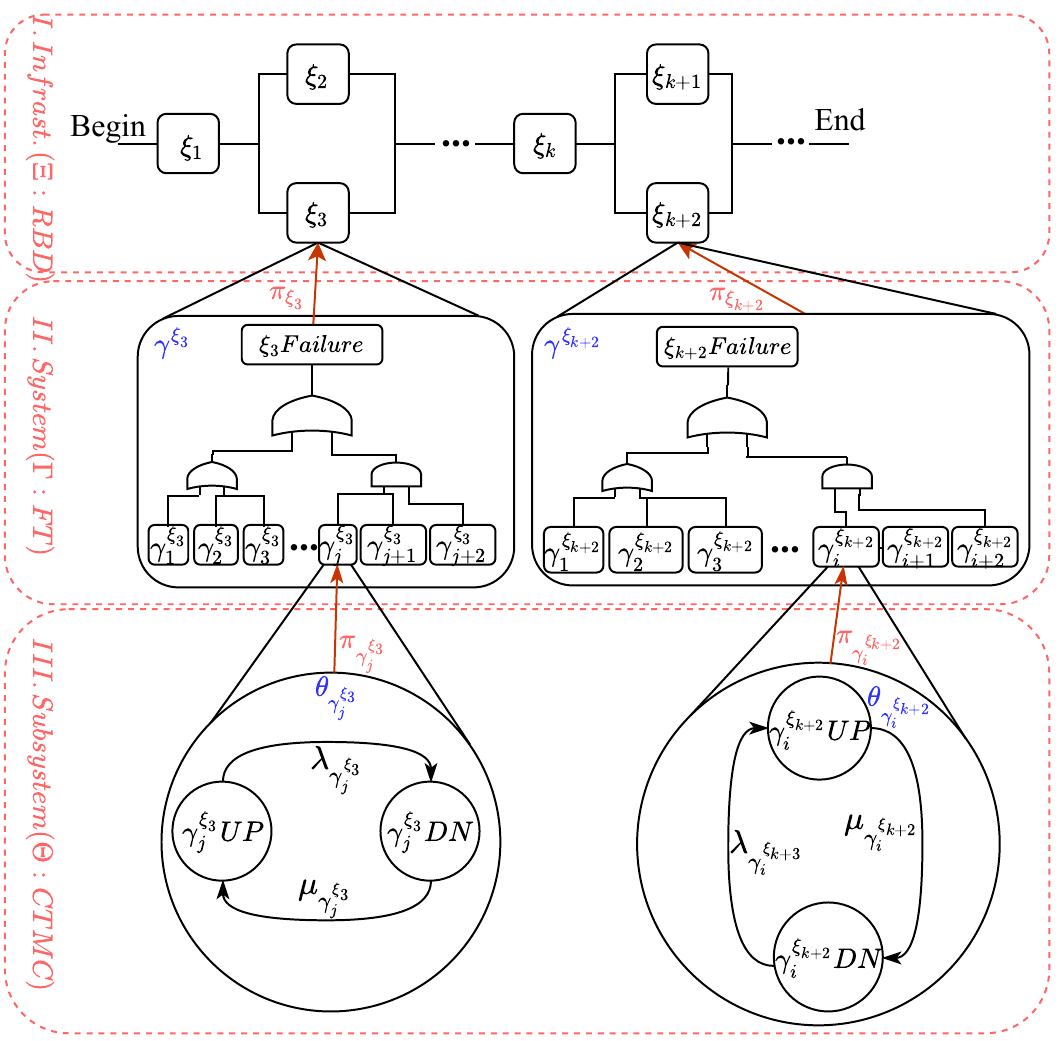
Figure 1. A hierarchical model for security and availability